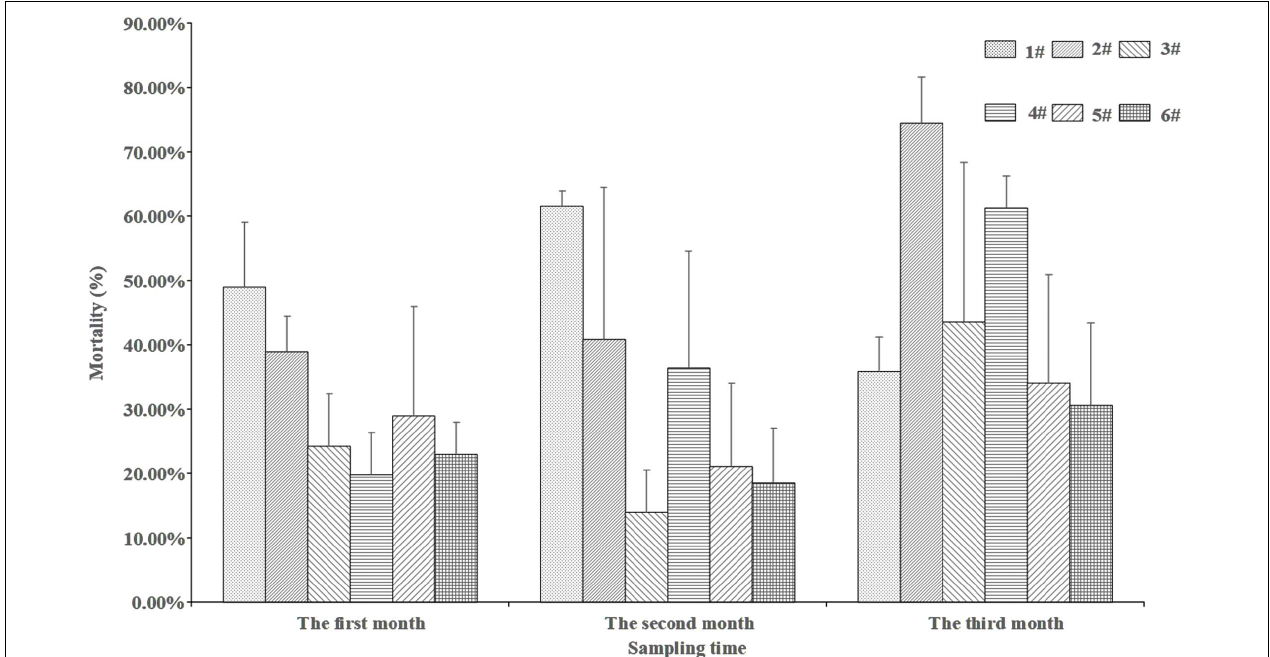
FIGURE 5 | Mortality of P. aibuhitensis larvae in different sampling time in different sediments. Error bars represent 1